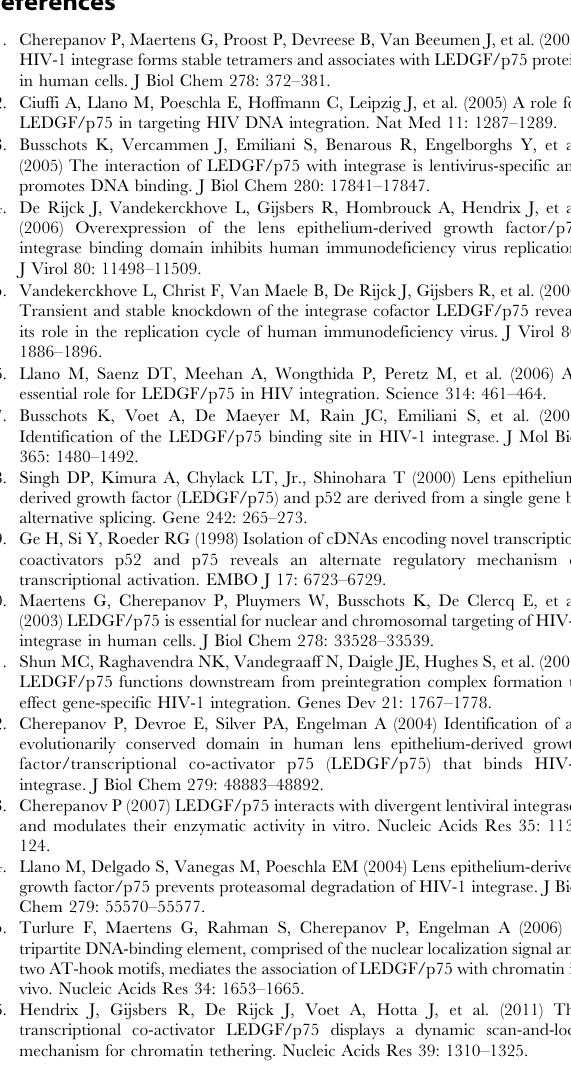
Table S3 Effect of LEDGF/p75 KD or KO on the frequency of viral integration in genomic features. Comparison of the HIV integration site distribution pattern elaborated in current and previous publications [2,11,17]. Frequency of viral integration in genomic features (integration in RefSeq genes, 6 2 kb or 6 4 kb around CpG islands) is